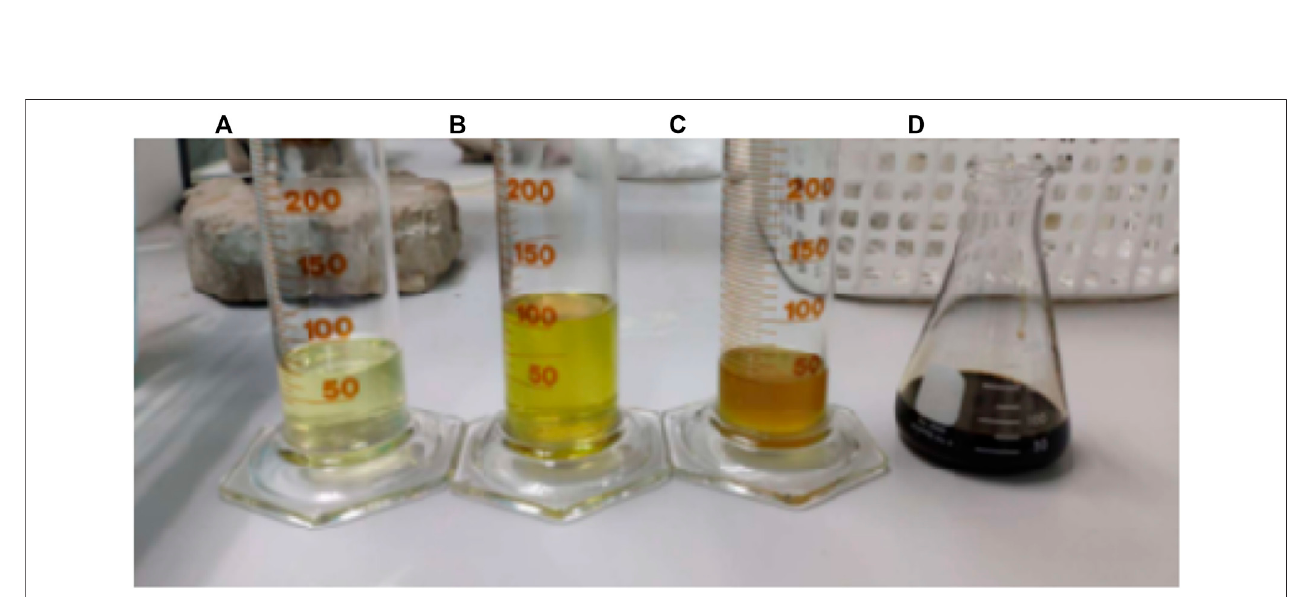
FIGURE13 | Productsobtained from the distillation ofthe pyrolysisoil from HDPEat thetemperature range of (A) 65 – 170, (B) 170 – 250, (C) more than 250 ° Cand (D) residue.